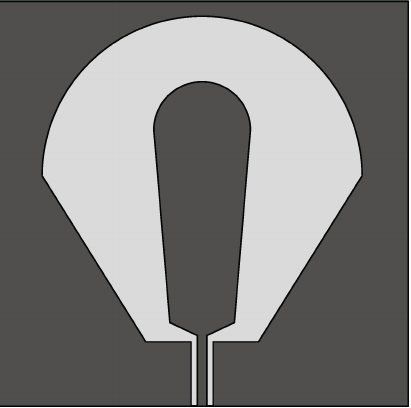
Figure 25. Schematic of a CPW-fed tapered arc slot antenna (redrawn from [97]). Dark gray metal face and light gray dielectric